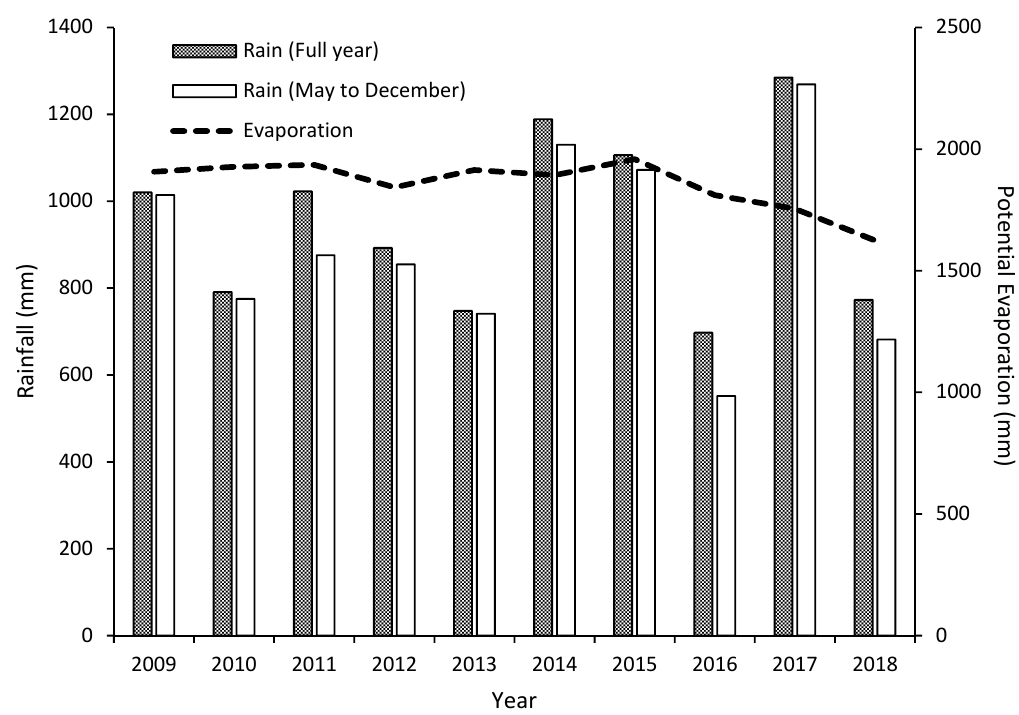
Figure 1. Annual rainfall, annual potential evaporation and rainfall from the beginning of May to the end of December for each year between 2009 and 2018. The measurement period and the full year of 2016 were the driest experienced at the site between 2009 and 2019.